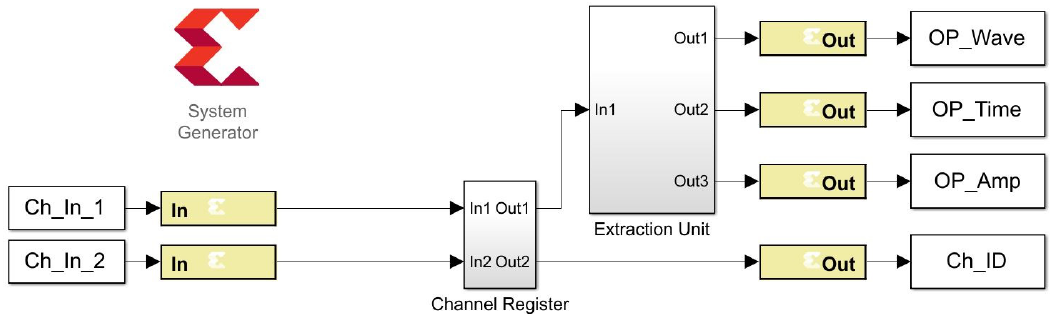
Figure 7. Design of a multichannel filtered input system (MCF) in